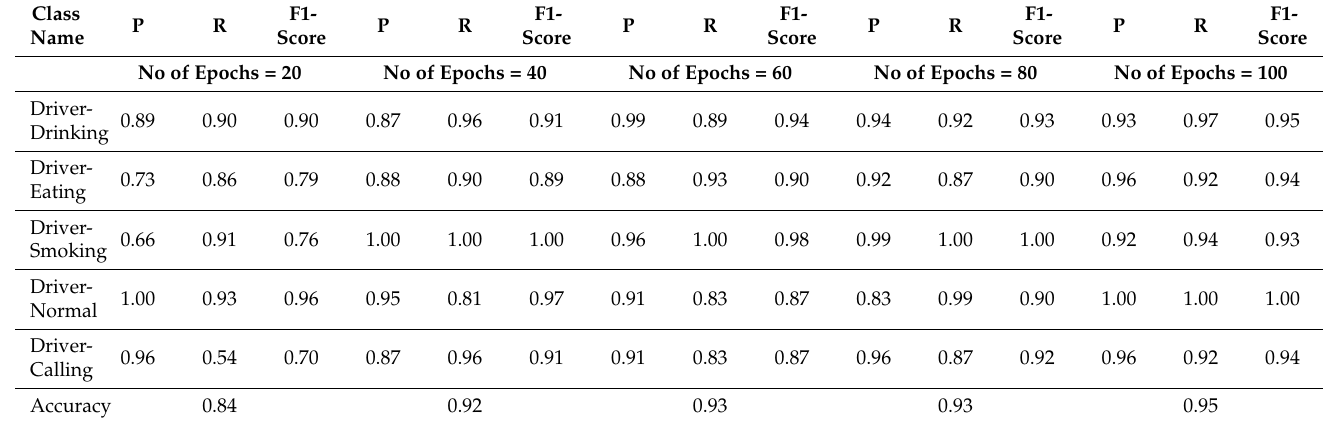
Table 2. Accuracy, Precision (P), Recall(R) and F1-Score using the 20, 40, 60, 80 and 100 epochs.